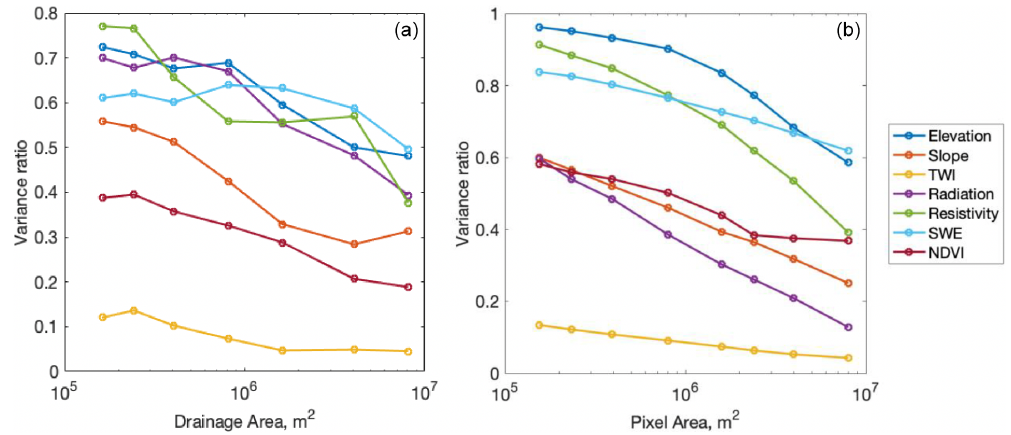
Figure 2. Variance ratio (a) between the across-hillslope variance and the overall variance as a function of the threshold drainage area and (b) between the across-upscaled-pixel variance and the overall variance as a function of the pixel area.